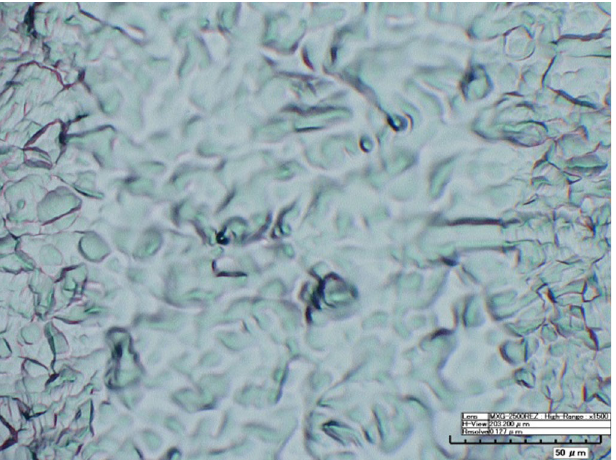
FIG. 9. Optical image of niobium surface after laser treatment with fluence 1 . 13 J = cm 2 , 34 pulses accumulation, and five tracks with 0.6 overlapping ratio between two tracks.